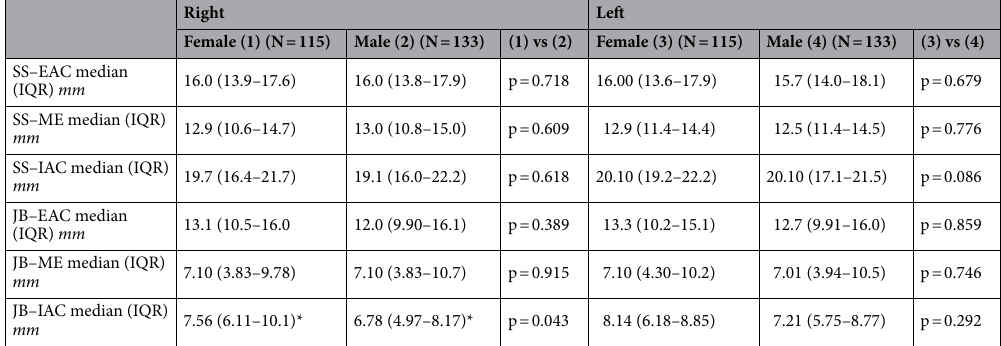
Table 3. Morphometric analysis (distance) of the sigmoid sinus and jugular bulb from ear region (external acoustic canal, middle-ear & internal acoustic canal) according to sex. mm millimeters, IQR Interquartile range, SS sigmoid sinus, JB jugular bulb, EAC internal acoustic canal, ME middle-ear, IAC internal acoustic canal. *Significant different with p < 0.05.